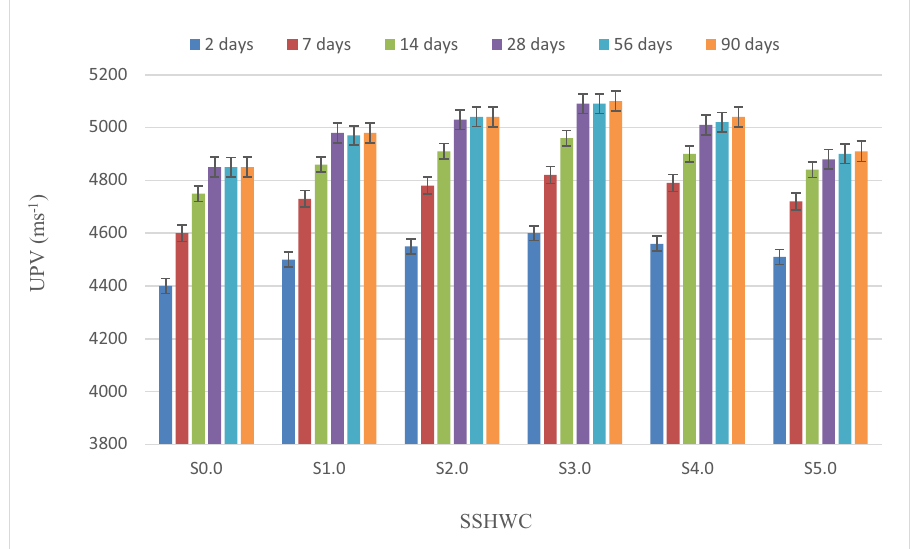
Figure 9: UPV of SSHWC mixes.